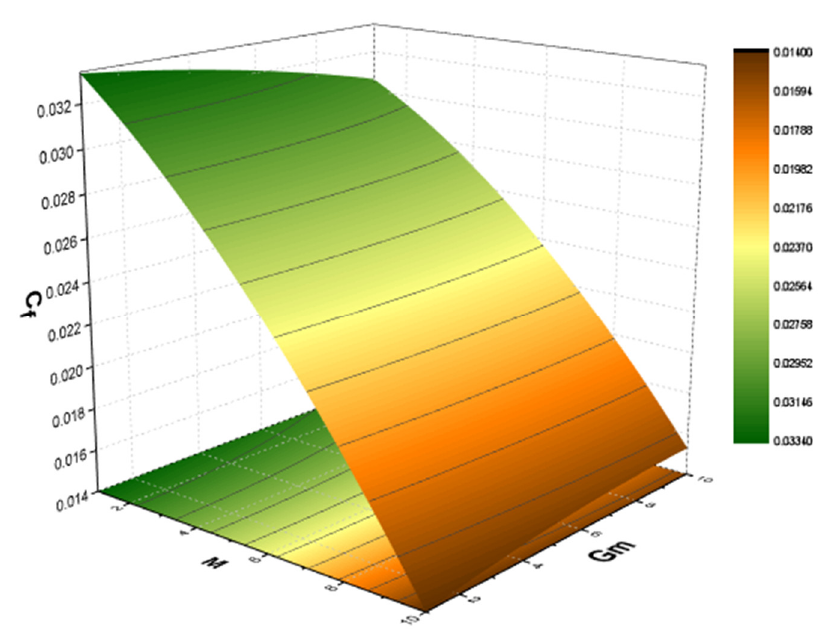
Figure 17. Impact of M and Gm on SF.